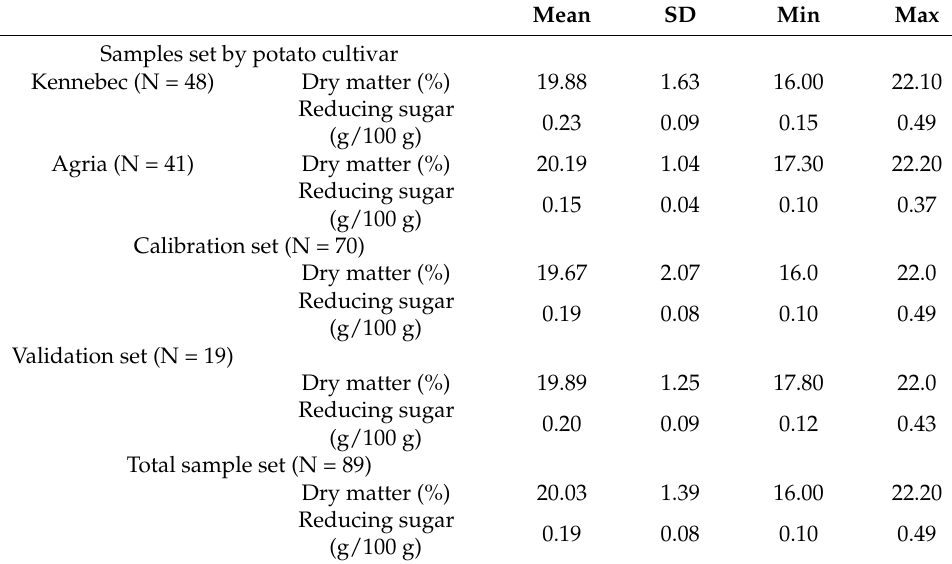
Table 1. An overview of the samples by potato cultivar and distribution by the calibration and validation